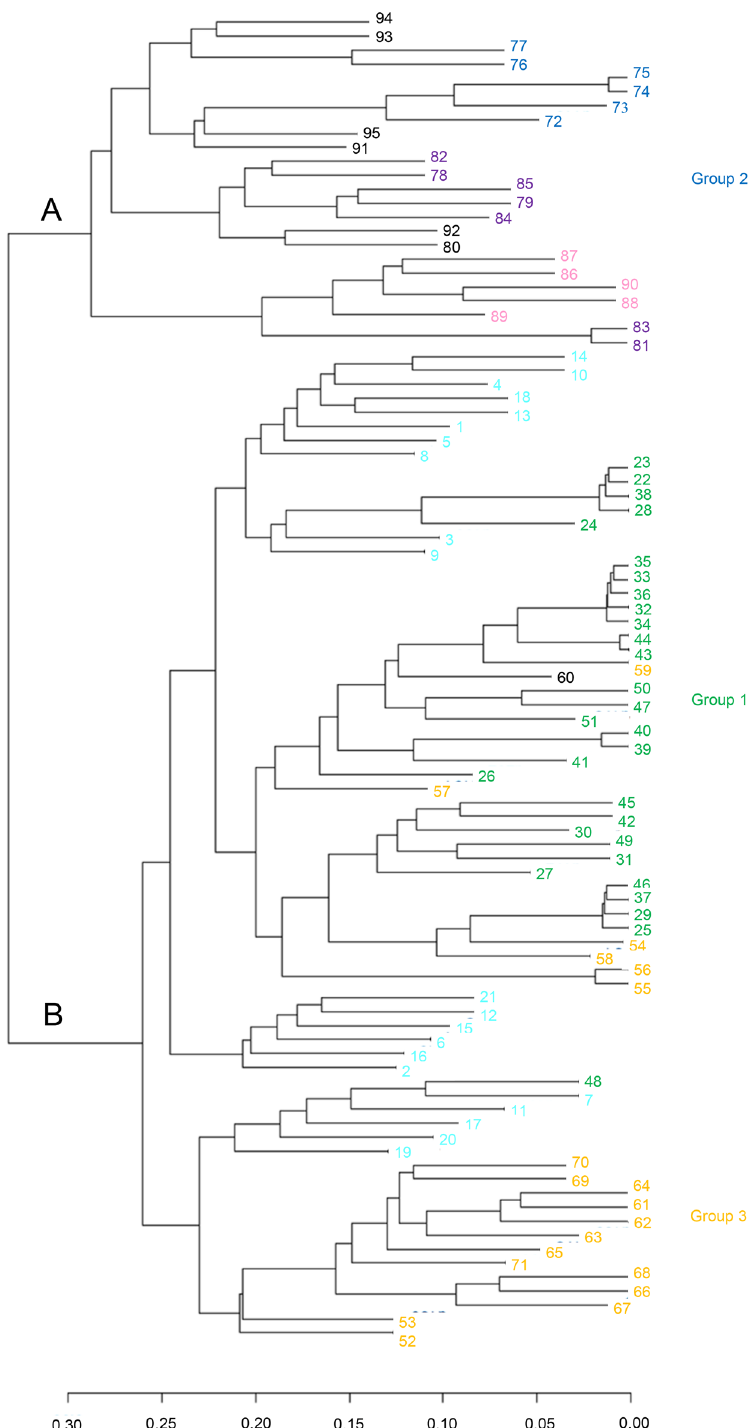
Figure 4. Cluster analysis of Eriobotrya japonica accessions. The color scheme is the same as in Fig. 2. Figure was generated using R software (version